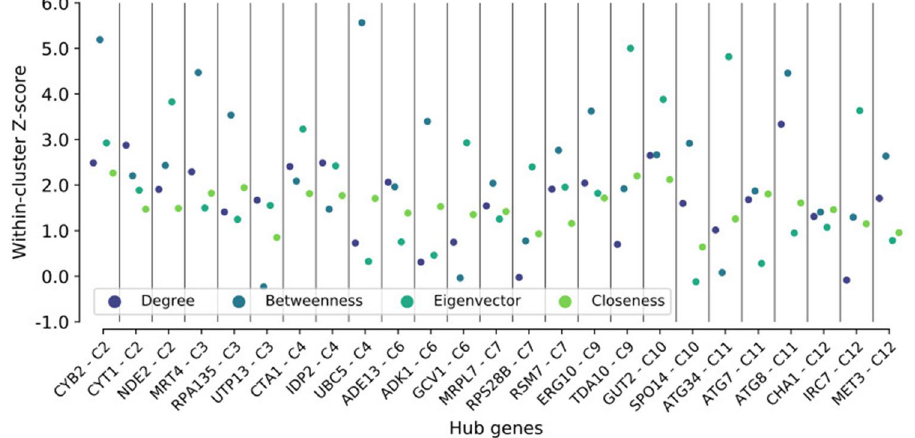
Figure 4. Hub genes are located in co-expressed gene clusters. Swarmplot showing the centrality scores (Y-axis) measured for the hub-genes selected from each cluster (X-axis). Each metric used is shown in a different